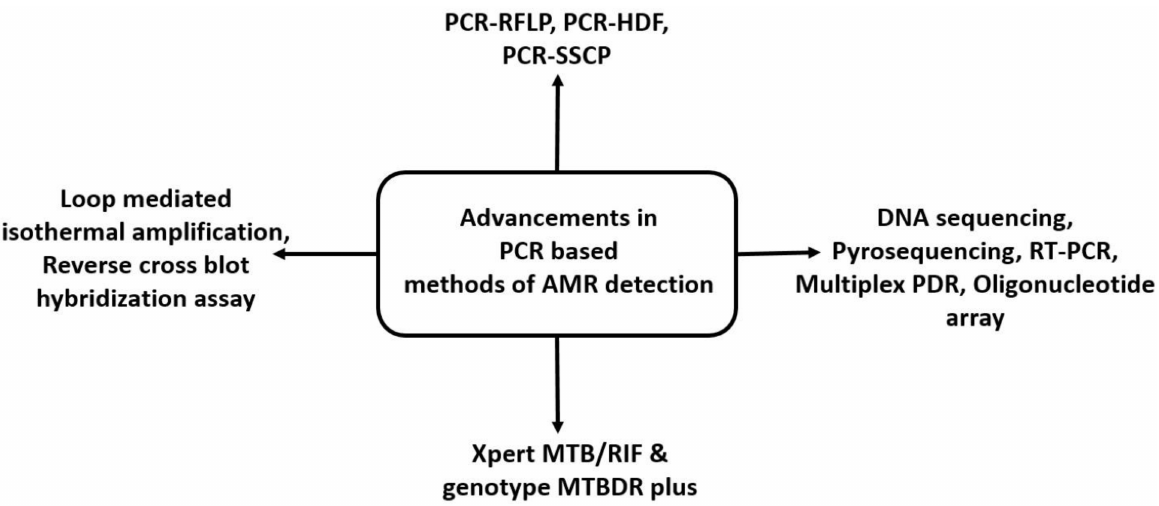
Figure 4. Nucleic acid detection method for drug resistance in M.tb based on PCR